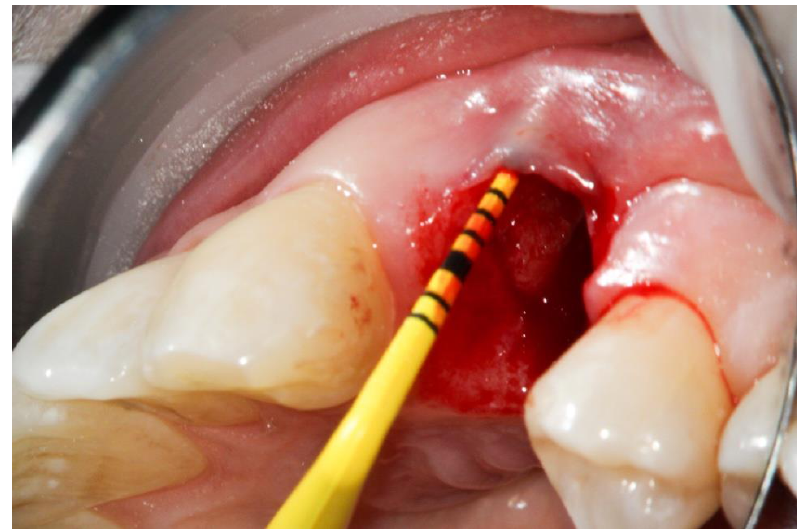
Figure 3. Compromised buccal lamella of tooth 14.